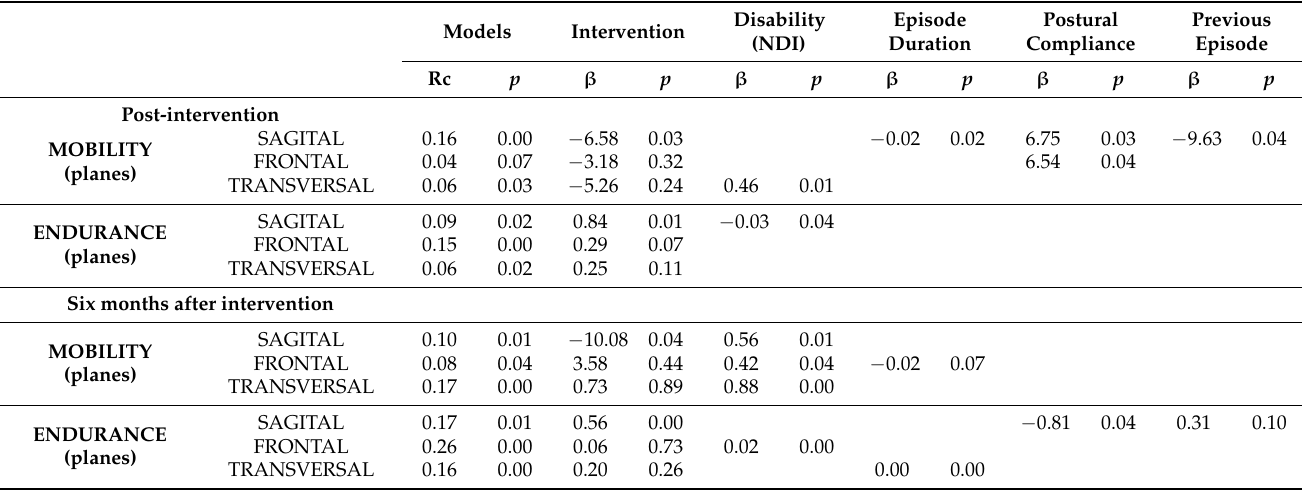
Table 4. Influence of study variables on cervical active mobility and endurance.